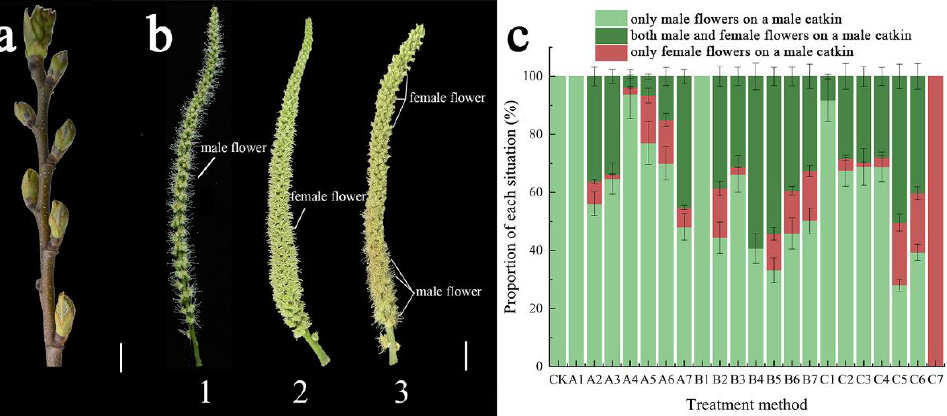
Figure 1. ( a ) The state of the first N-(2-chloro-4-pyridyl)-N’-phenylurea (CPPU)-treated catkins; 1. Only male flowers on male catkin; 2. Only female flowers on female catkin; 3. Both male and female flowers on male catkin; ( b ) The sex of flowers on male catkins in Casatanea henryi ; ( c ) The proportions of different sexes of the flower on the male catkins under different treatments of Casatanea henryi . All scale bars = 10 mm.